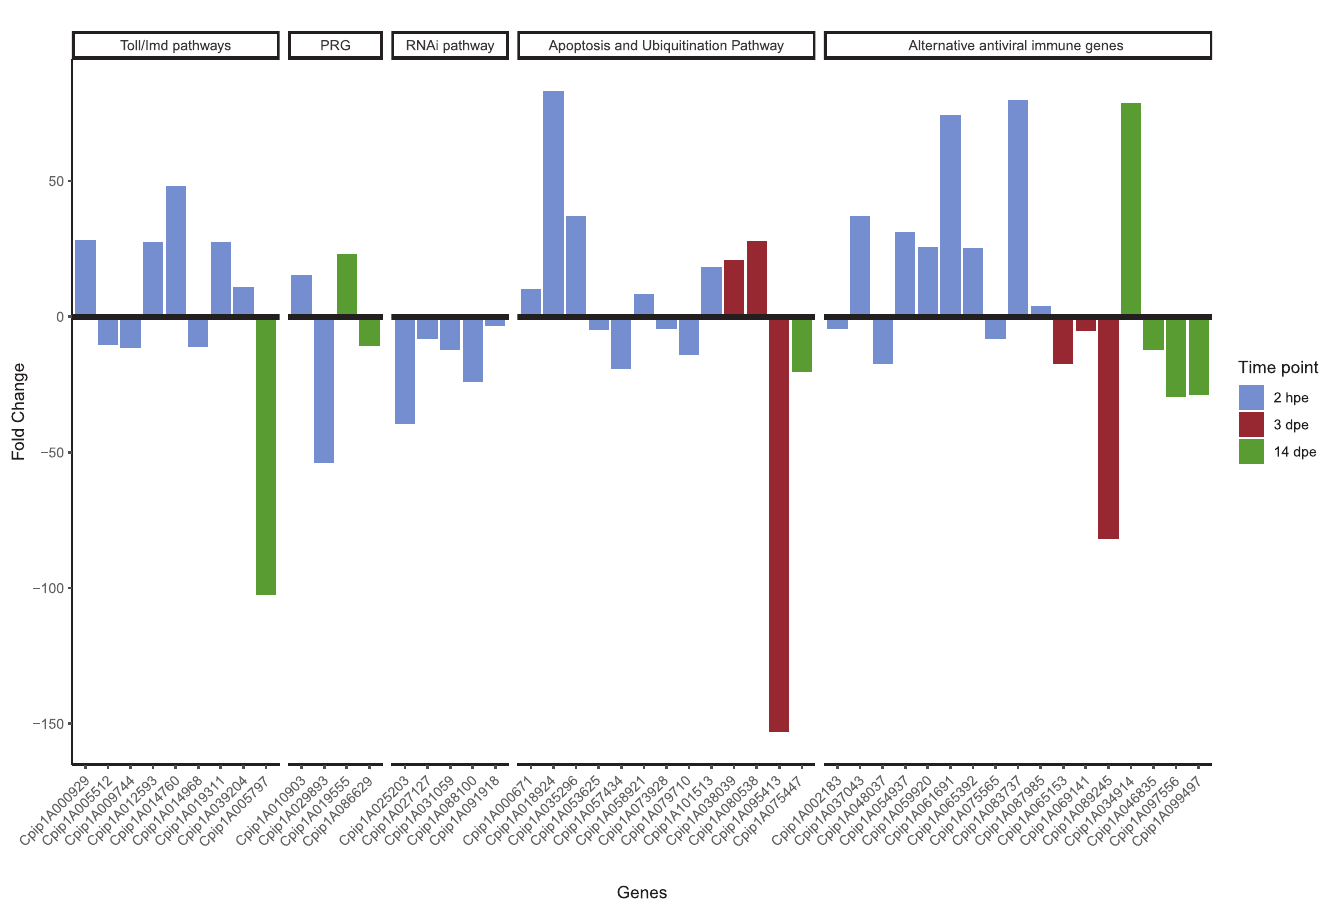
Fig 3. Evolution of the immune infection-response upon RVFV exposure in Cx . pipiens mosquitoes. The immune DEG altered at 2 hpe, 3 and 14 dpe are represented in blue, red and green colors, respectively. PRG: Pathogen recognition genes.